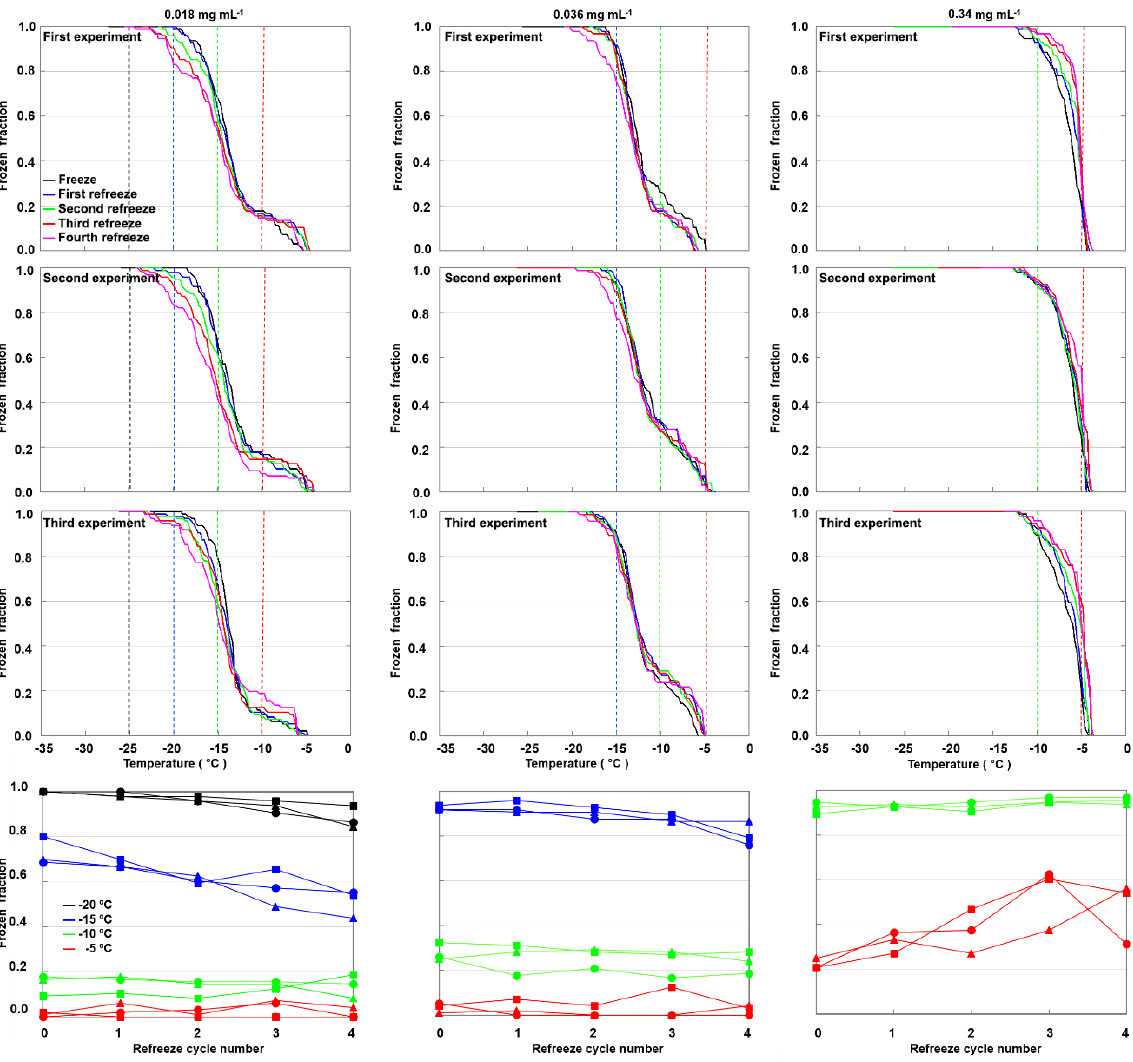
Figure 12. Refreeze experiments with apoferritin (batch 2) solutions with concentrations of 0.018mgmL − 1 (first column), 0.036mgmL − 1 (second column), and 0.34mgmL − 1 (third column). Frozen fractions are given for the first freeze–thaw cycle (cycle 0) and four refreeze cycles. For each concentration three independent preparations were investigated (rows 1–3). Experiments were analysed with respect to the frozen fraction at − 5, − 10, − 15, and − 20 ◦ C (row 4).